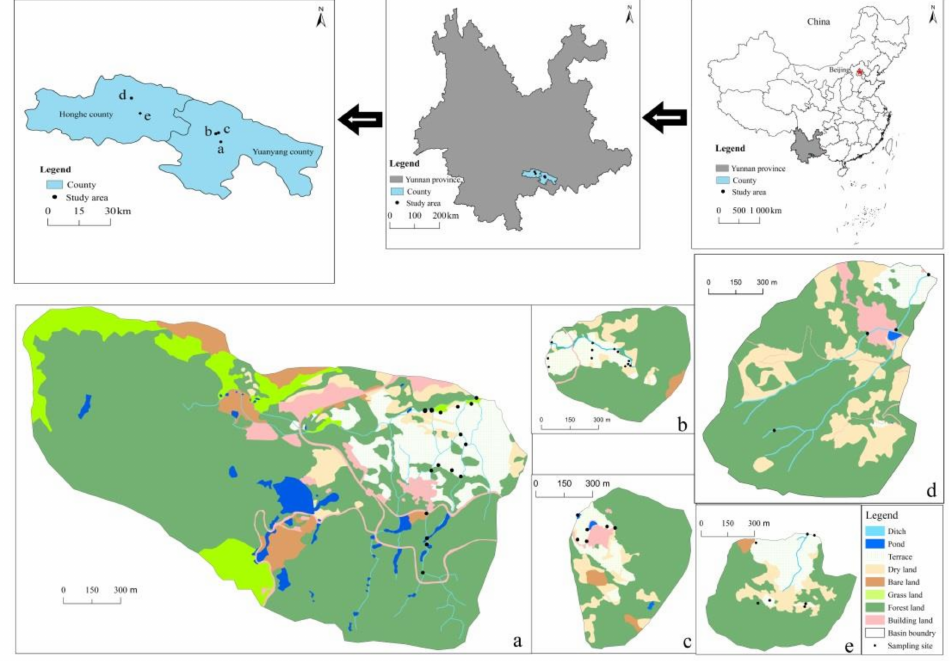
Figure 1. Location, land use types and water sampling sites of the study